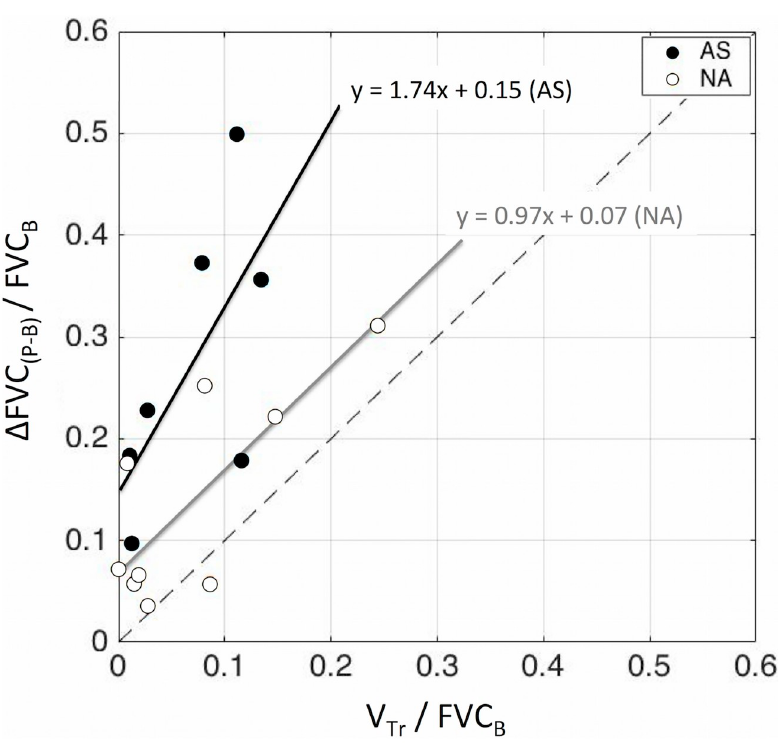
Fig 8. Measured relative drop in FVC from baseline to post MCh ( Δ FVC (P-B) /FVC B ) plotted as a function of the sum of volumes estimated to be trapped behind closing segmental airways during a force vital capacity maneuver ( V Tr /FVC B ). Each data point corresponds to a subject of the AS (blue) and NA, (red) groups.